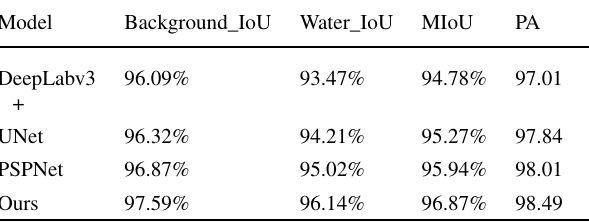
Table 2 Comparison of different model indicators